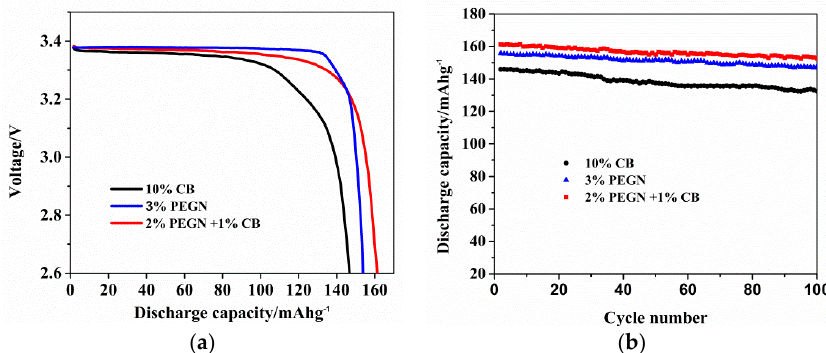
Figure 8. ( a ) Discharge curves and ( b ) cycle performance of LiFePO 4 @PEGN/CB, LiFePO 4 @PEGN, and LiFePO 4 @CB.